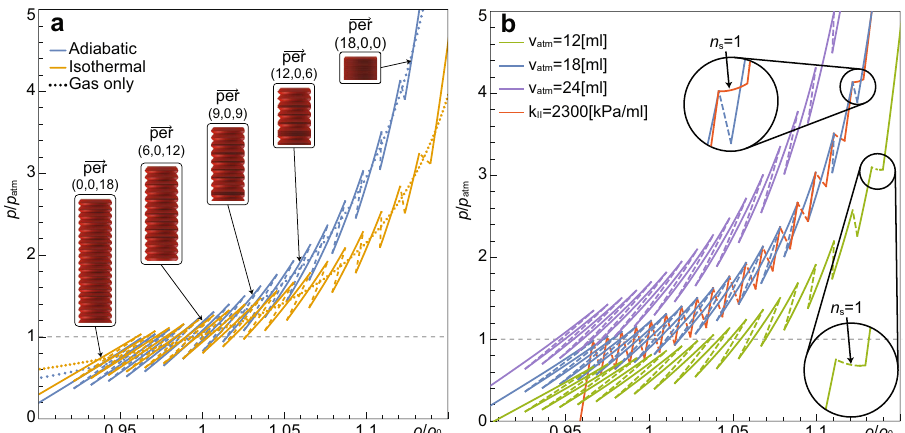
Fig. 3 Stability and the equation of state. Analytical results for pressure ( p / p atm ) vs. density ( ρ / ρ 0 ) for stable (solid lines) and unstable (dashed lines) equilibria states. The system parameters used are listed below (see caption of Fig. 4). a Comparison between adiabatic (blue lines) and isothermal (orange lines) processes. Dotted lines represent ideal gas. b Examining the effect of v atm , the volume of the gas encapsulated in a single capsule at atmospheric pressure, and k II , the slope of phase II. The blue line is a reference curve based on experimental values, with v atm = 18 ml and k II = 152 kPa ml − 1 . The green and purple lines are pressure-density curves for fl uid with decreased and increased values of v atm of 12 ml and 24 ml, respectively. The red line is a pressure-density curve in which one of the unstable permutations is stabilized (see inset), achieved by setting k II = 2300 kPa ml − 1 , while keeping all other parameters identical to the blue reference curve. The insets show that decreasing v atm or increasing k II creates regions where the fl uid is stable although a bi-stable element is at the spinodal region.